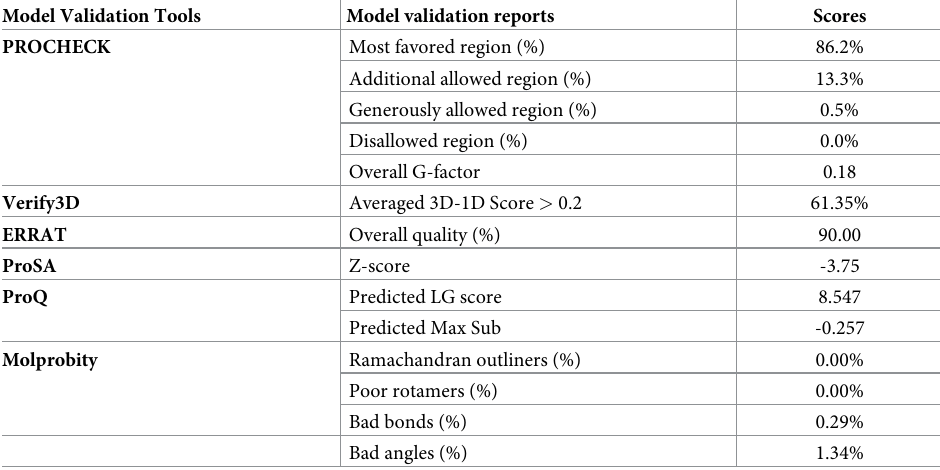
Table 1. Model validation scores of yam bean mosaic virus coat protein (YBMV